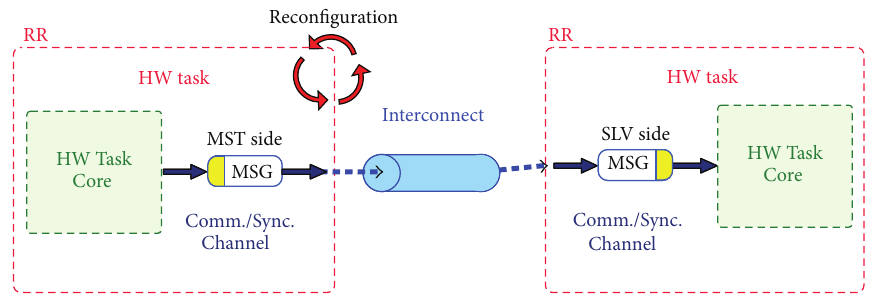
Figure 13: Channel with reconfigurable